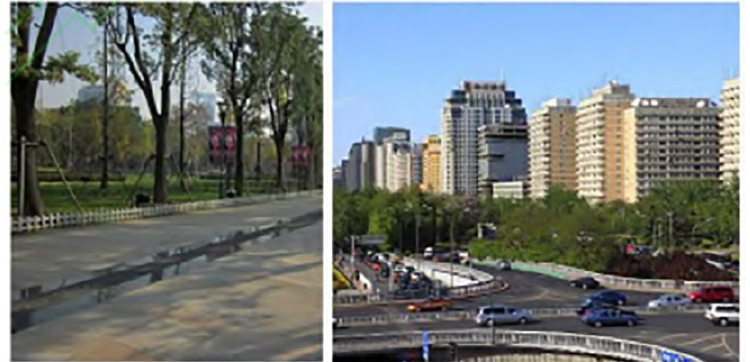
Figure A1. Urban streetscape taken at 8:00 a.m.